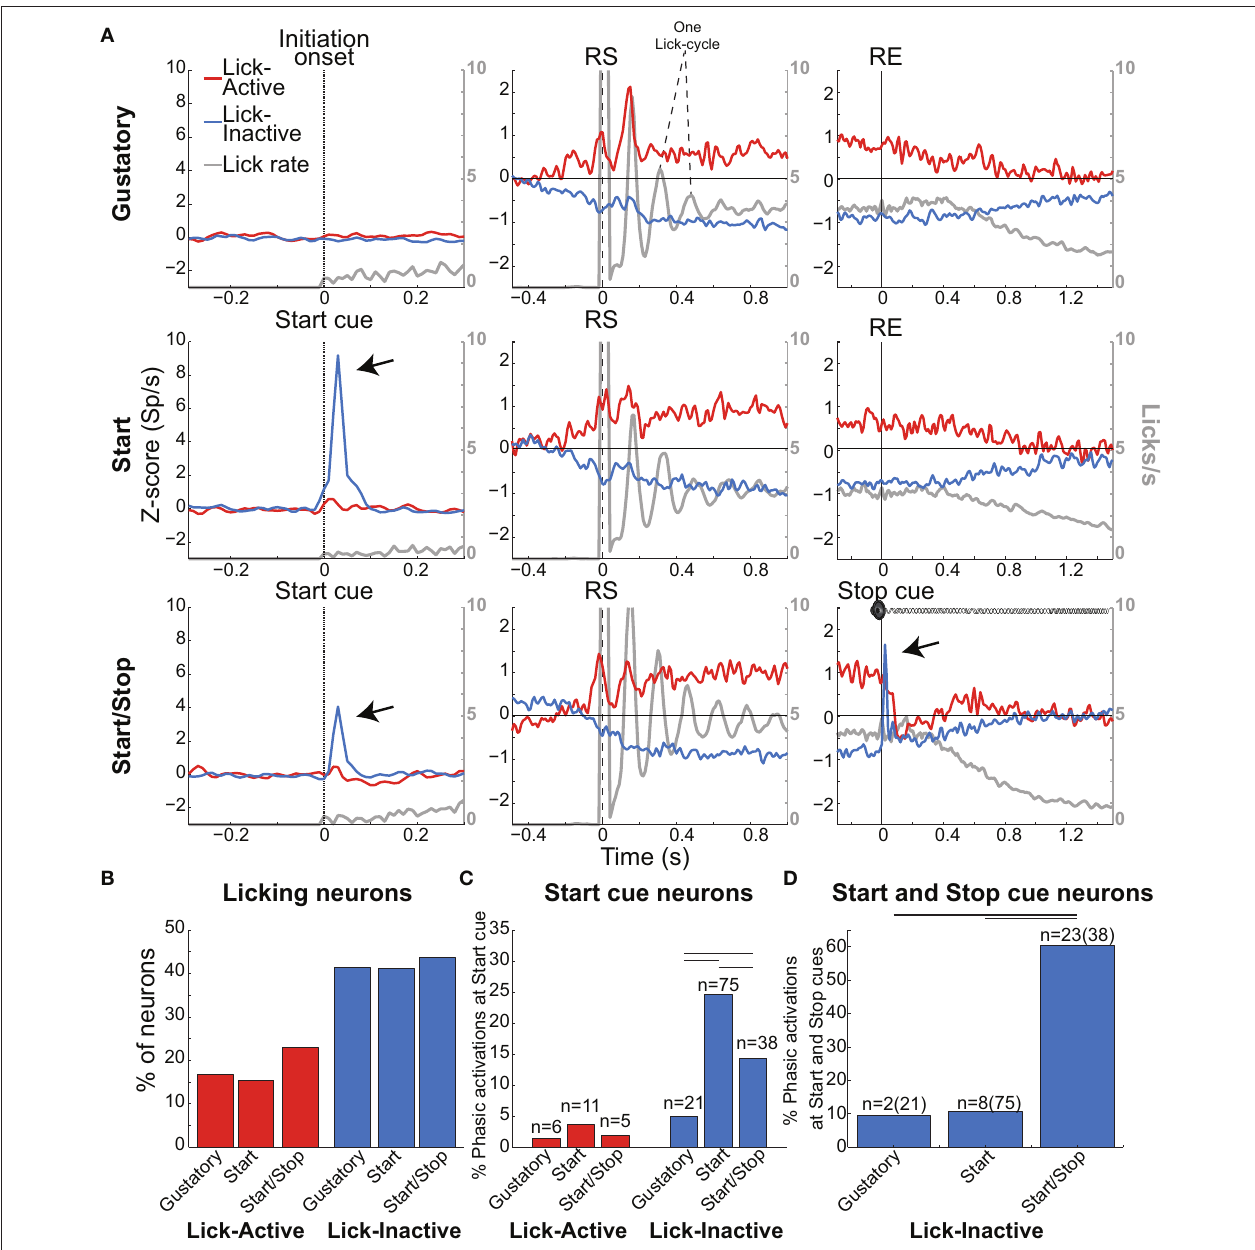
FIGURE 6 | Lick-Inactive NAcSh neurons respond phasically to both the Start and Stop auditory cues. (A) The population activity of neurons (Z-score) that was either Active (red) or Inactive (blue) for times around the initiation of licking and during and after the Reward epoch for the Gustatory (upper), Start (middle) and Start/Stop test (bottom panels). Responses to all (Total) licks (licks/s) are shown in gray and the time between peaks indicates one lick cycle ( ∼ 150ms) and aligned to the onset of the Initiation epoch (for the Gustatory test) and the Start cue for the Start and Start/Stop tests (left column). For each brief-access test neuronal responses were also realigned to the reward start (RS -middle column) and the reward end (RE (right column). The arrows shown in the Lick-Inactive neurons point to the auditory–evoked phasic activation by both the Start and Stop cues (in Start/Stop and Start tests). Times from − 1.5 to − 0.5s before the Initiation epoch were always used as the baseline. (B) Histogram for each test of the percentage of neurons that sustain an Active or Inactive modulation during licking. (C) Histogram showing the percentage of Lick-Active or Lick-Inactive neurons with a significant phasic modulation at the Start cue. (D) The proportion of Lick-Inactive neurons that responded phasically to both the Start (Click) and Stop cues (white noise). Horizontal lines in (C,D) indicate significant differences among tests at an alpha of 0.05 (chi-squared